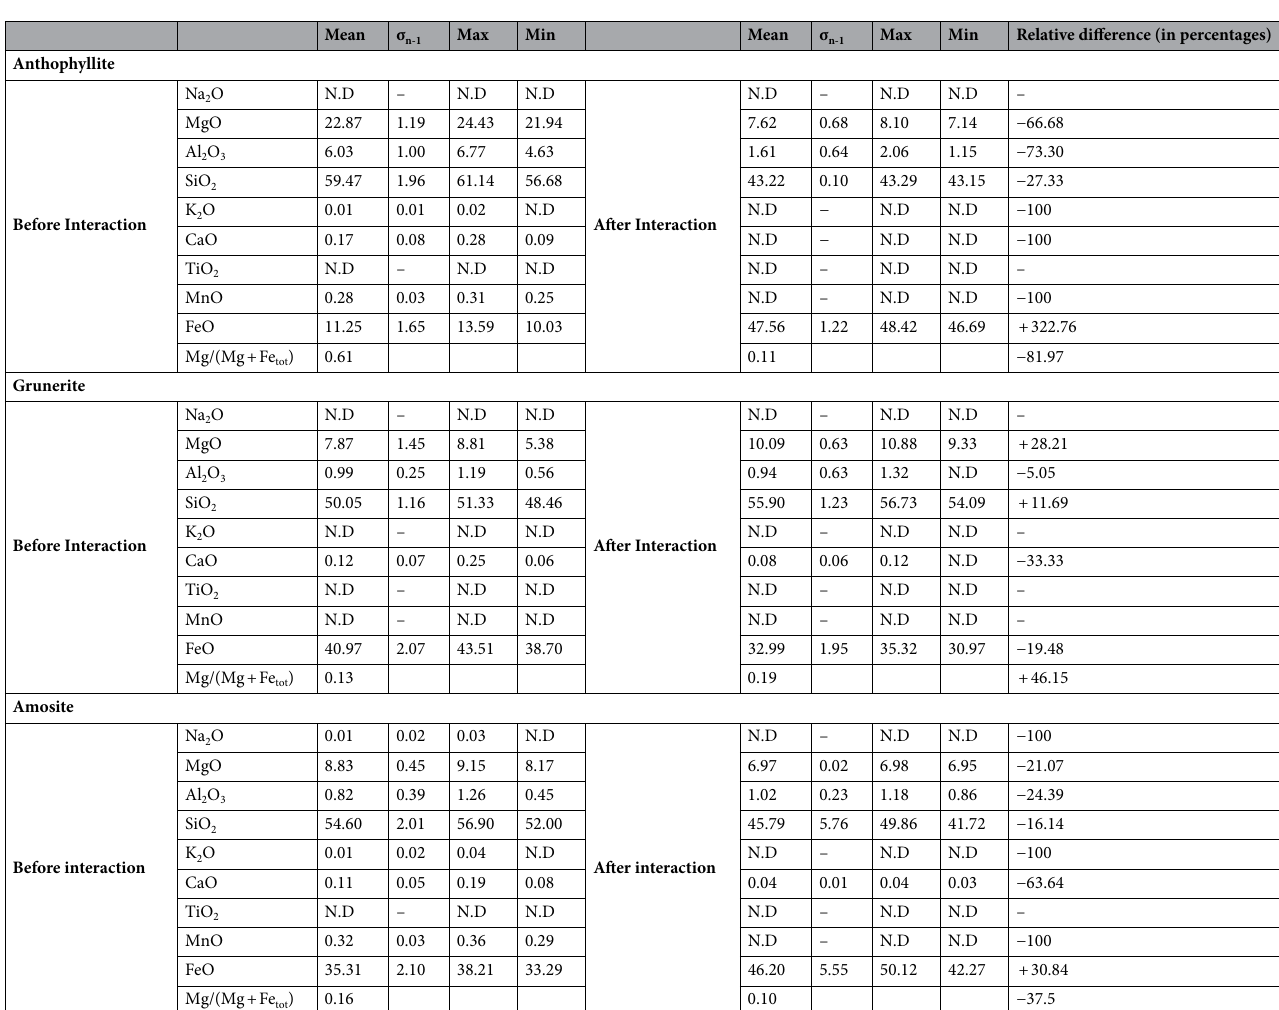
Table 2. Oxide composition (in wt%) of the amphibole particles before (starting material) and after (retrieved from cells) the interaction with AECs. Data obtained by acSTEM-EDXS bulk analyses. Before the interaction: n = 100 for each of the minerals; after the interaction: n = 19, 24 and 59 for anthophyllite, grunerite and amosite, respectively. N.D = not